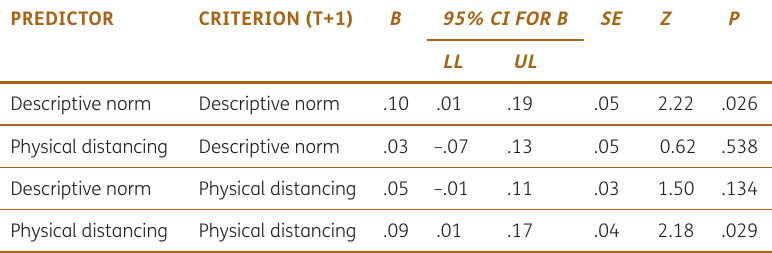
Table 10 Random Intercept Cross-lagged Panel Model for the School Sample. Note : N = 464.